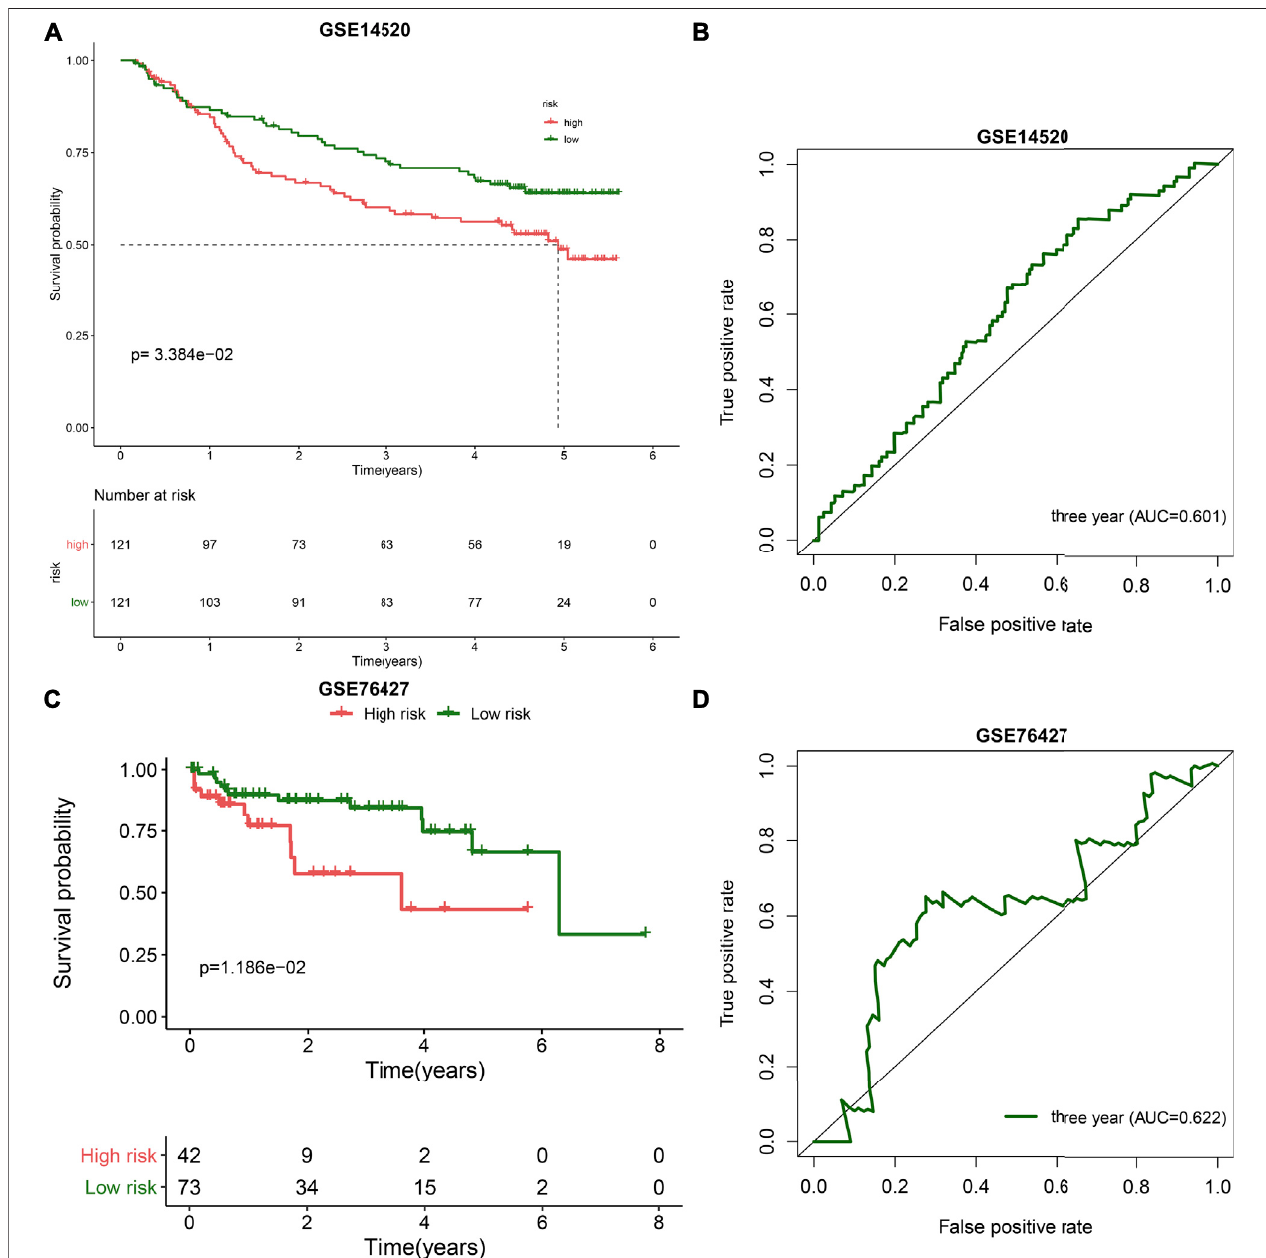
FIGURE 2 | External validation of the TLR-based gene signature in the GSE14520 and GSE76427 datasets. (A) Kaplan-Meier curves of high and low RS HCC patients in the GSE14520 dataset. Survival differences were estimated through log-rank tests. (B) ROC curve of 3-year OS for HCC patients according to the RS in the GSE14520dataset. (C) Kaplan-MeiercurvesofhighandlowRSHCCpatientsintheGSE76427dataset.Survivaldifferenceswereestimatedthroughlog-ranktests. (D) ROC curve of 3-year OS for HCC patients according to the RS in the GSE76427